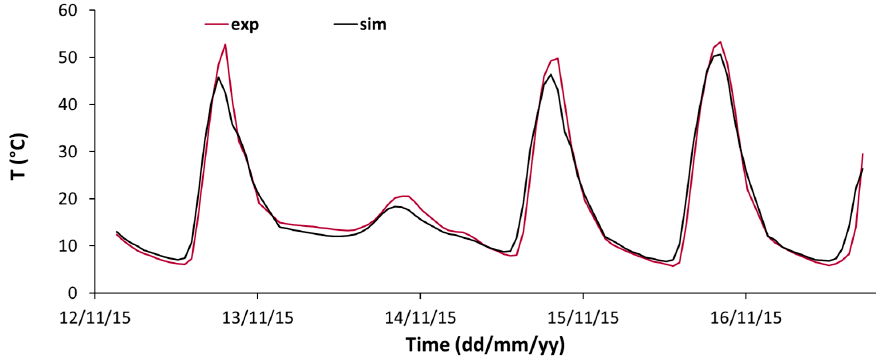
Figure 6. Temperature profiles of NF, measured and simulated, after the calibration procedure.